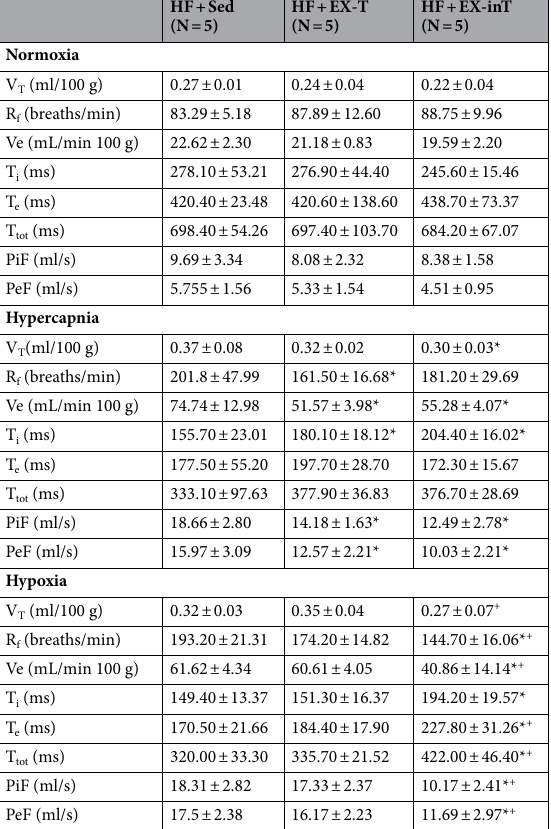
Table 2. Resting ventilatory parameters during normoxia (F i O 2 21%), hypoxia (F i O 2 10%), and hypercapnia